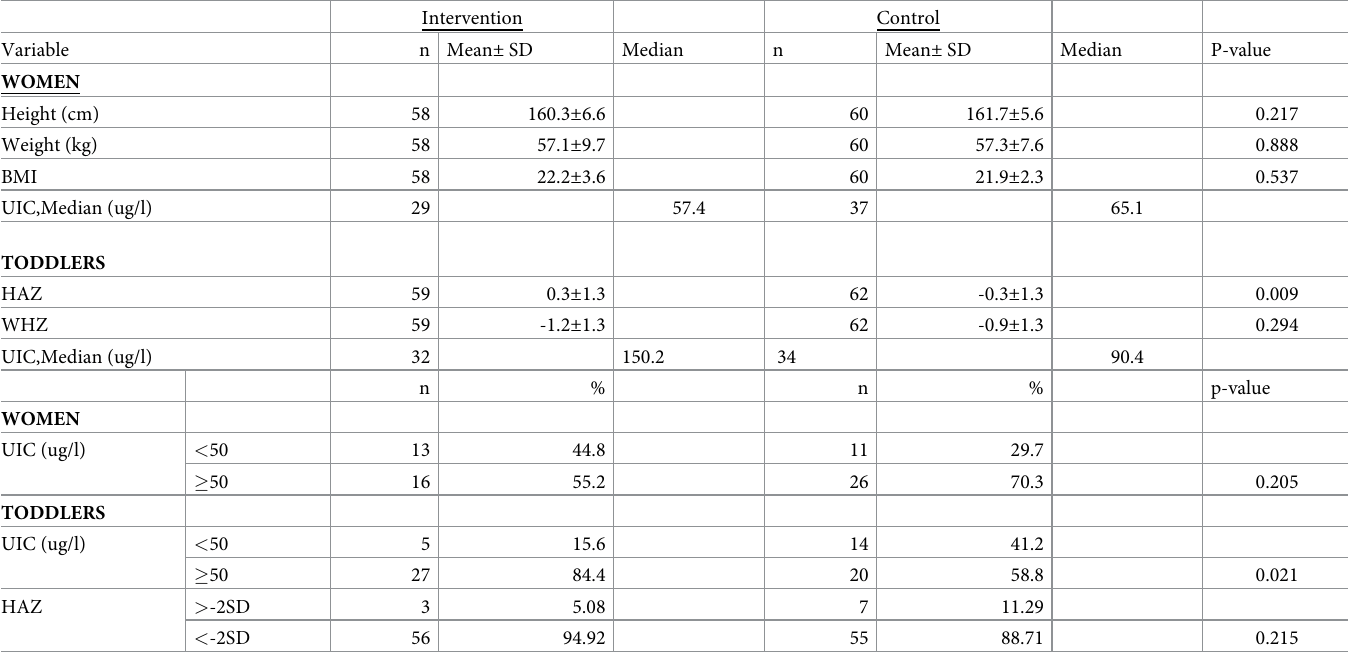
Table 2. Baseline health indicators of child bearing age women (15–49 yrs) and their toddlers (6–23 mo) in intervention and control groups. Intervention Control Variable n Mean ± SD Median